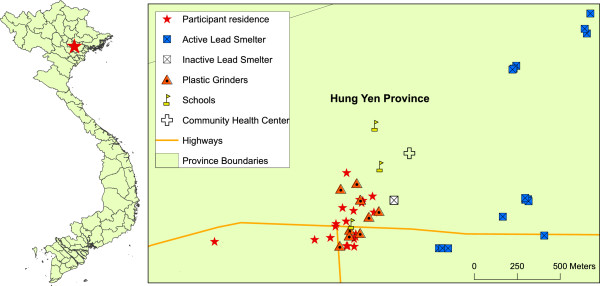
Children in Nghia Lo, Vietnam live in close proximity to lead smelters. Nine plastic grinders and 18 active or inactive smelters are located within three km of the Nghia Lo village.